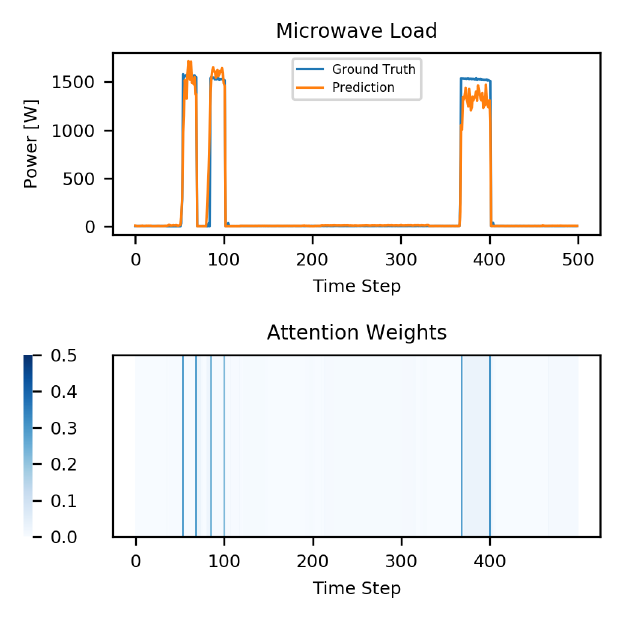
Figure 5. REDD microwave load and the heatmap of the attention weights at 3 s